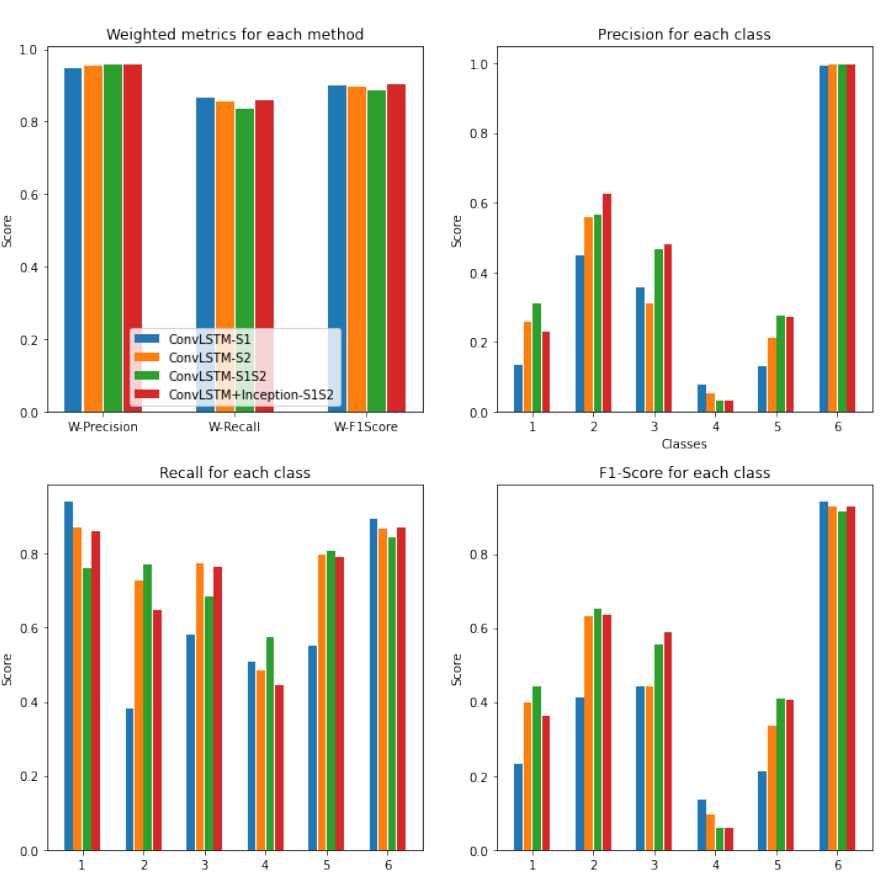
Figure A1. Bar plot results of all methods for the test zone located in the west of the Grand-Est region for 6 semantic classes.